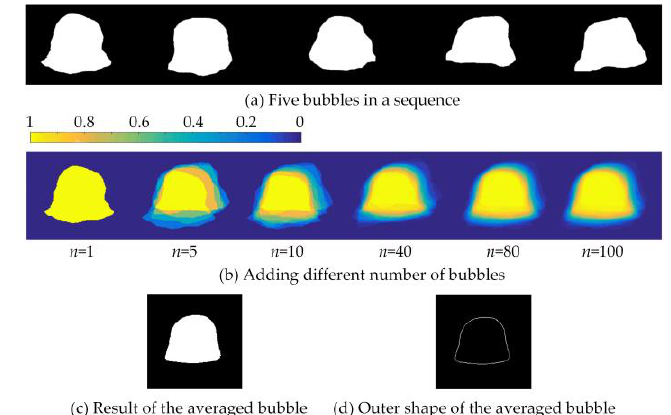
Figure 9. Averaging of bubbles. ( a ) Five bubbles in a sequence; ( b ) Adding different number of bubbles; ( c ) Result of the averaged bubble; ( d ) Outer shape of the averaged bubble.